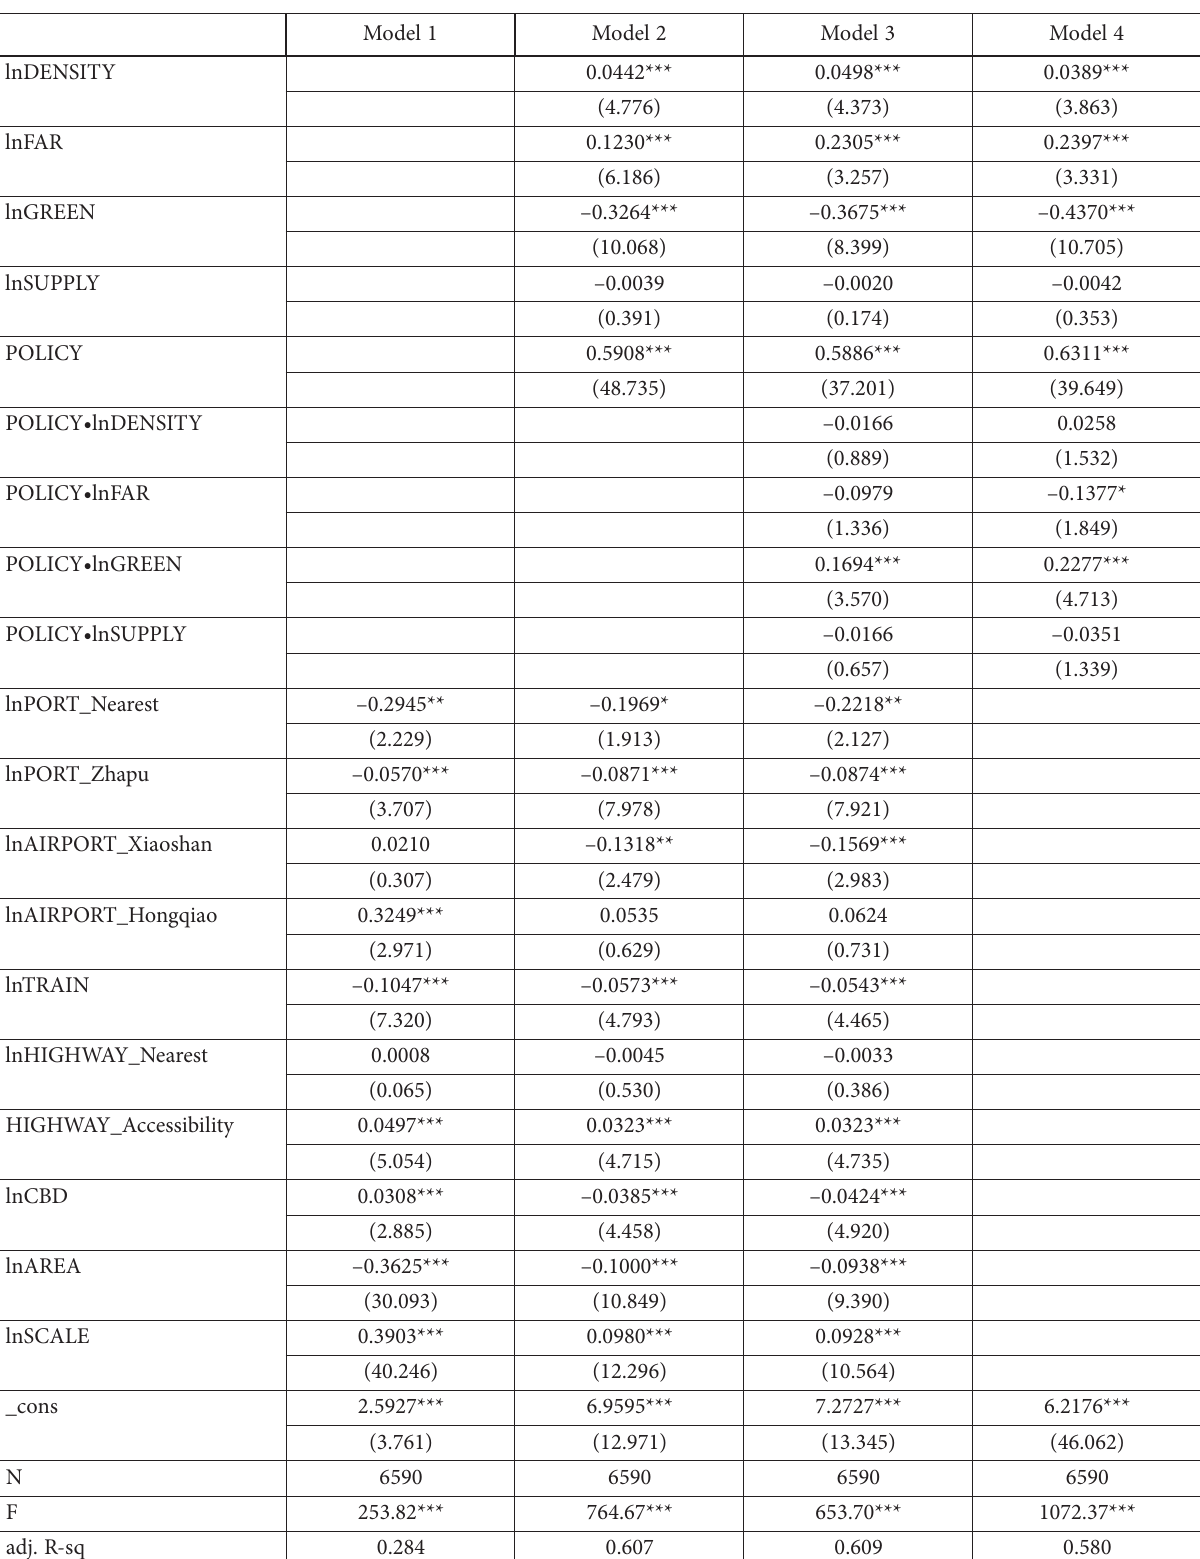
Table 2. Results of the regression model of the impact of land use regulation on industrial land